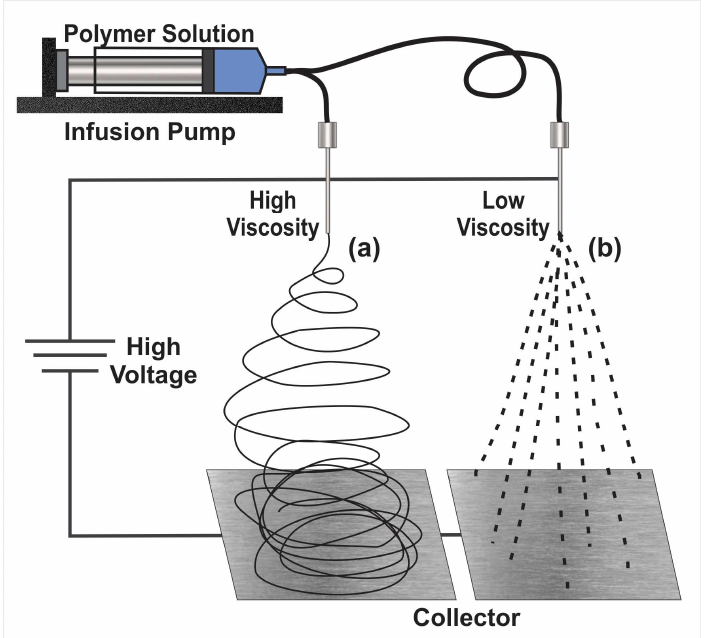
Figure 1. Basic setup for the electrodynamic method to produce either nanoparticles or nanofibers. ( a ) Electrospinning and ( b ) electrospray.